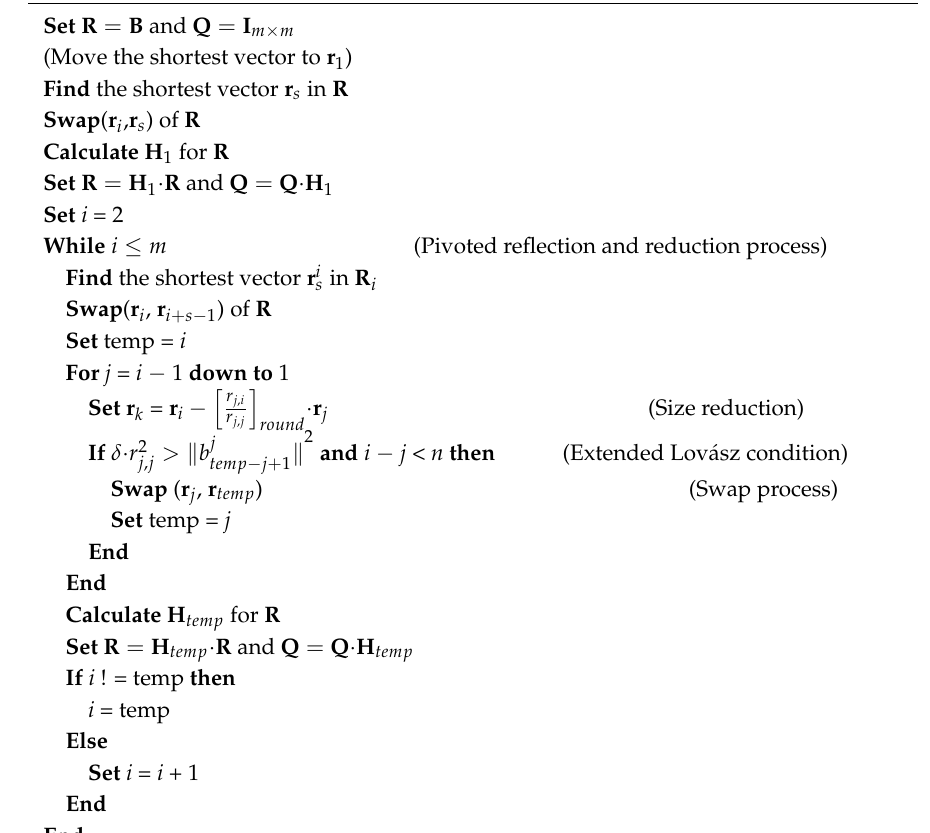
Algorithm 3: The n -LLL reduction with pivoted